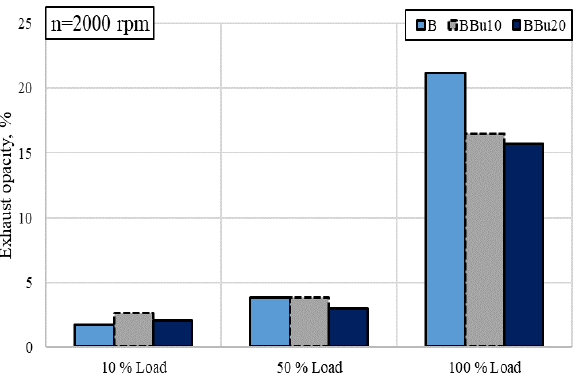
Fig. 6. Dependencies of smoke opacity of the exhaust on engine load when running at maximum torque speed of 2000 rpm When running the engine on biofuel blends BBu10 and BBu20 at full (100%) load at maximum torque speed of 2000 rpm, the smoke opacity decreased by 28.5% and 35%, respectively, compared to the cases of using neat